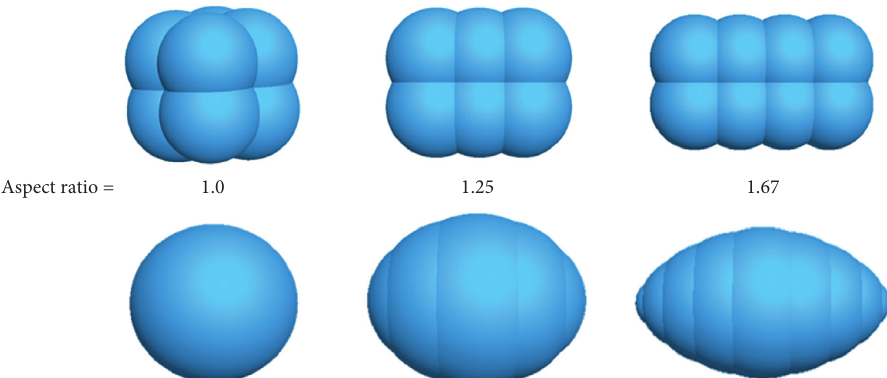
Figure 14: Arrangement of shape test for DEM numerical simulation.